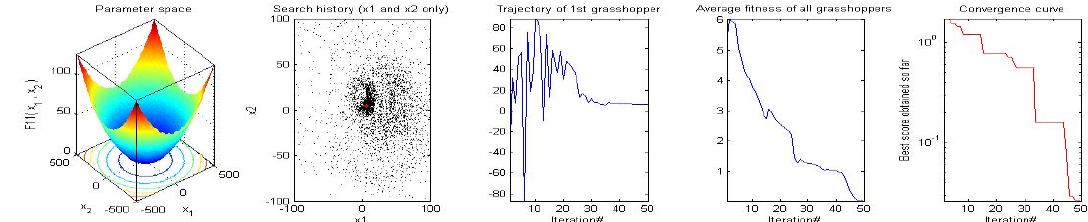
Figure 12. HAGOA behavior on multimodal function (F11)